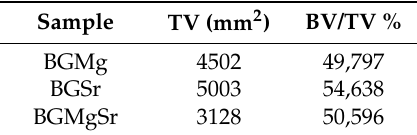
Table 6. Amount of newly formed bone present inside the osteotomic gap expressed as BV/TV% (histomorphometric